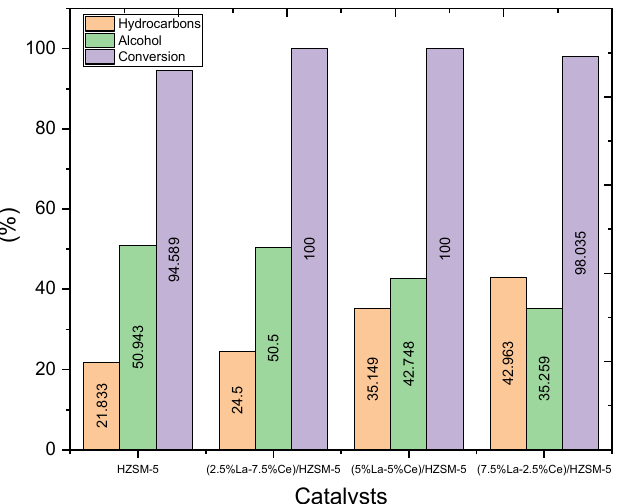
Figure 15. The conversion percentage of the algal HO and the yield percentages of the outstanding chemicals of the hydrocarbons and alcohol from the catalytic deoxygenation of the algal HO for the parent HZSM-5 zeolite and Lanthanum-Cerium-modified HZSM-5 zeolite with different loading weight percentages (batch reactor, 300 °C, 1000 rpm, 7 bar N 2 initial gas (inert gas), catalyst-to-algal HO ratio = 15% (wt.%), and 6 h).